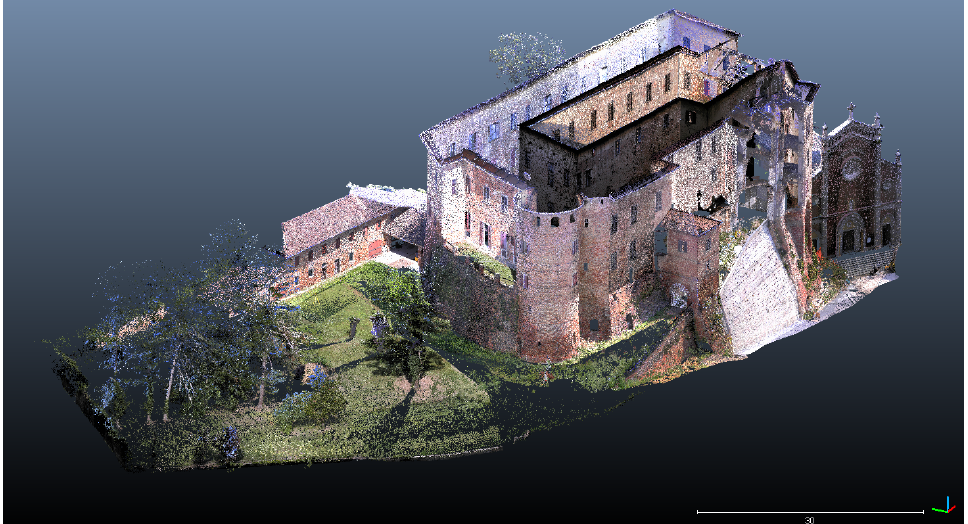
Figure 4. Trimble SX10 external point clouds of the castle and surroundings (point dimension 1